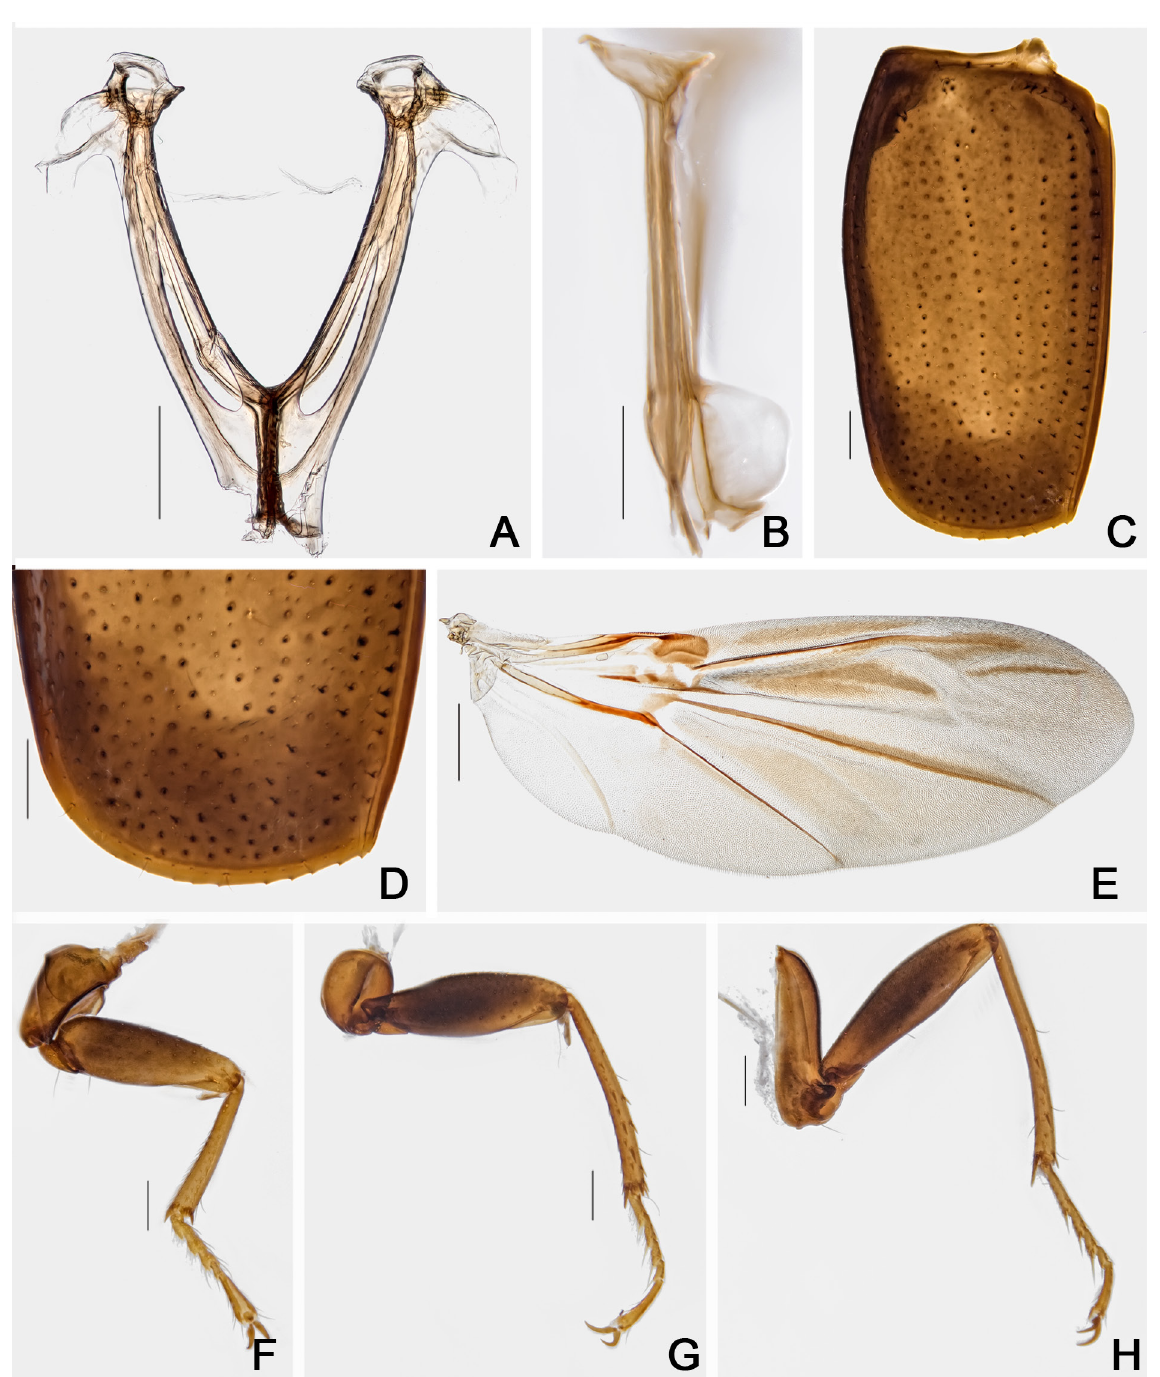
Fig. 51. Cyparium collare Pic, 1920, ♂ (CELC). A–B . Metendosternite. A . Dorsal view. B . Lateral view. C–D . Elytron. C . Entire. D . Apex. E . Hind wing. F–H . Legs. F . Fore. G . Middle. H . Hind. Specimen collected at Mata do Paraíso, Viçosa (MG, Brazil). Scale bars: A–D, F–H = 0.2 mm; E = 0.5